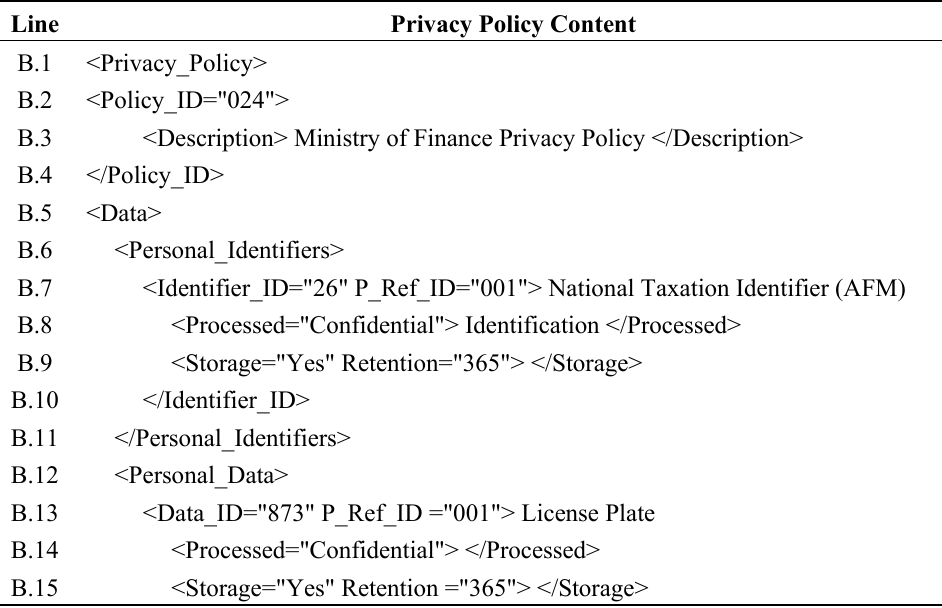
Table 2. Ministry of Finance Privacy